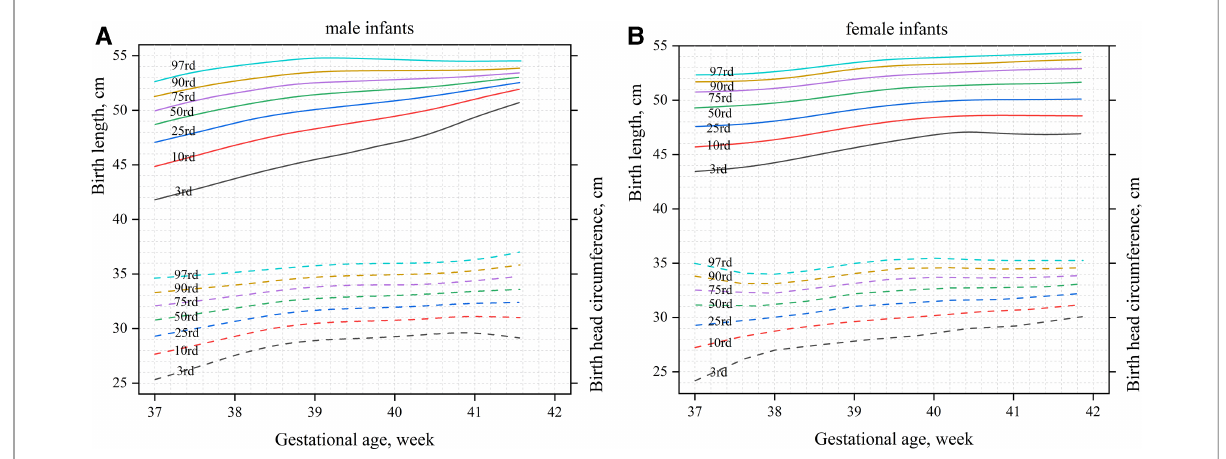
FIGURE 2 Percentile curves of the length and head circumference by gender and gestational age ( A ): male infants; ( B ): female infants.